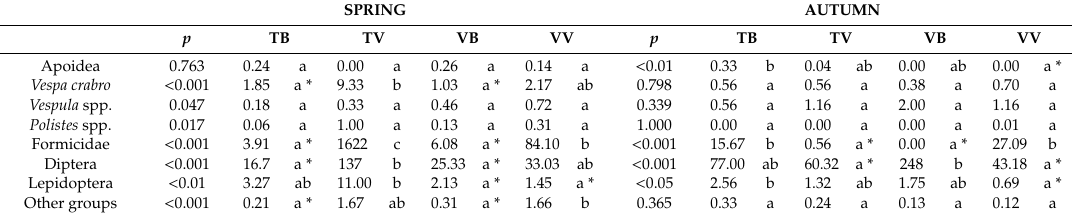
Table 3. Results of the Fisher’s exact test and of the pairwise test of independence with Bonferroni correction for the analysis of the selectiveness. For each comparison, p -values of the Fisher’s exact test are reported. Values for each trap–bait combination represent the ratio non-target insects: V. velutina . Letters define similarities among groups in agreement with a pairwise test of independence with Bonferroni correction; letters are ordered alphabetically in relation to their degree of selectiveness (a * = higher degree of selectiveness than the other trap–bait combination). SPRING AUTUMN TB